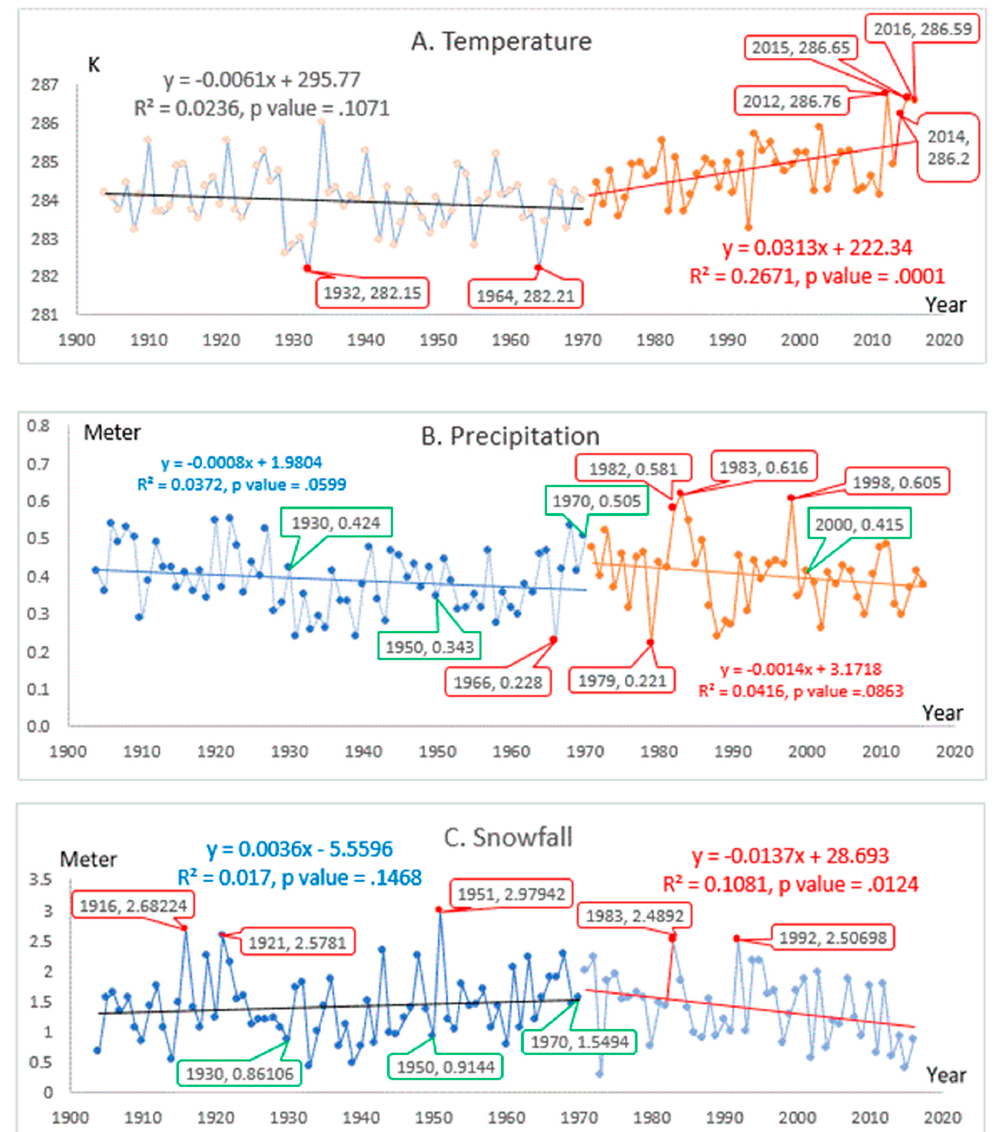
Figure 3. The dynamics of temperature, precipitation, and snowfall in the GSL area. ( A ) trend analysis of temperature; ( B ) trend analysis of precipitation; and ( C ) trend analysis of